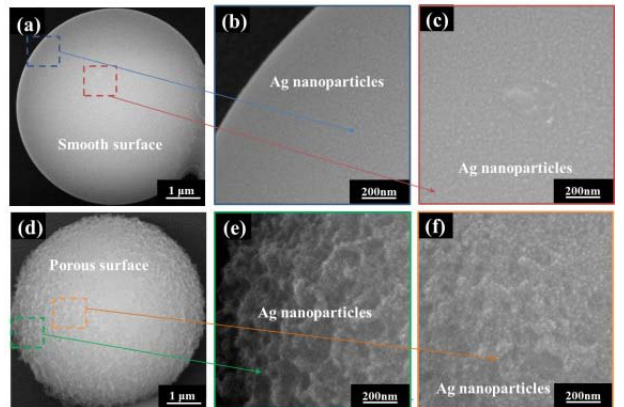
Figure 6. Light-induced conglobation of Ag nanofilms on carbon spheres with smooth and porous surfaces. ( a ) Low-magnification image of Ag nanoparticles on carbon spheres with smooth surfaces; ( b , c ) surface morphologies of carbon sphere in the margin and center; ( d ) low-magnification image of Ag nanoparticles on carbon spheres with smooth surfaces; ( e , f ) surface morphologies of carbon sphere in the margin and center.